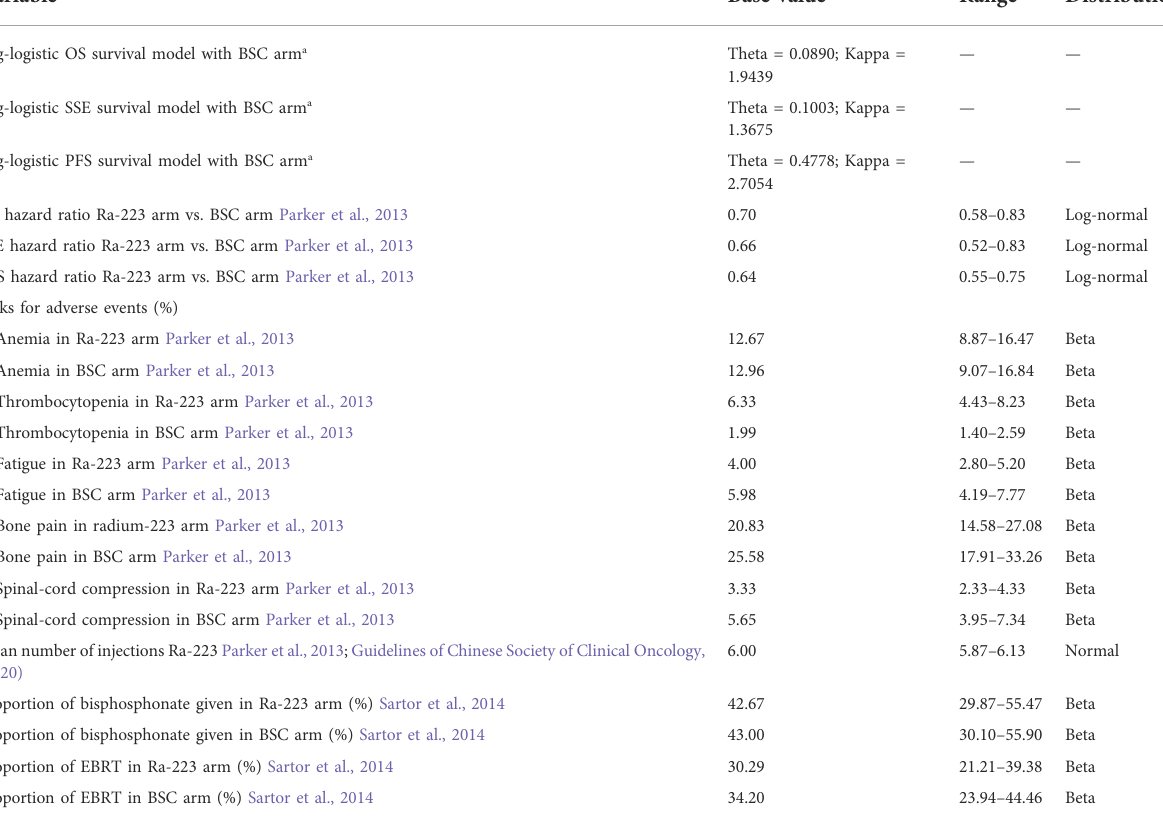
TABLE 1 Model input parameters estimated or derived from the clinical